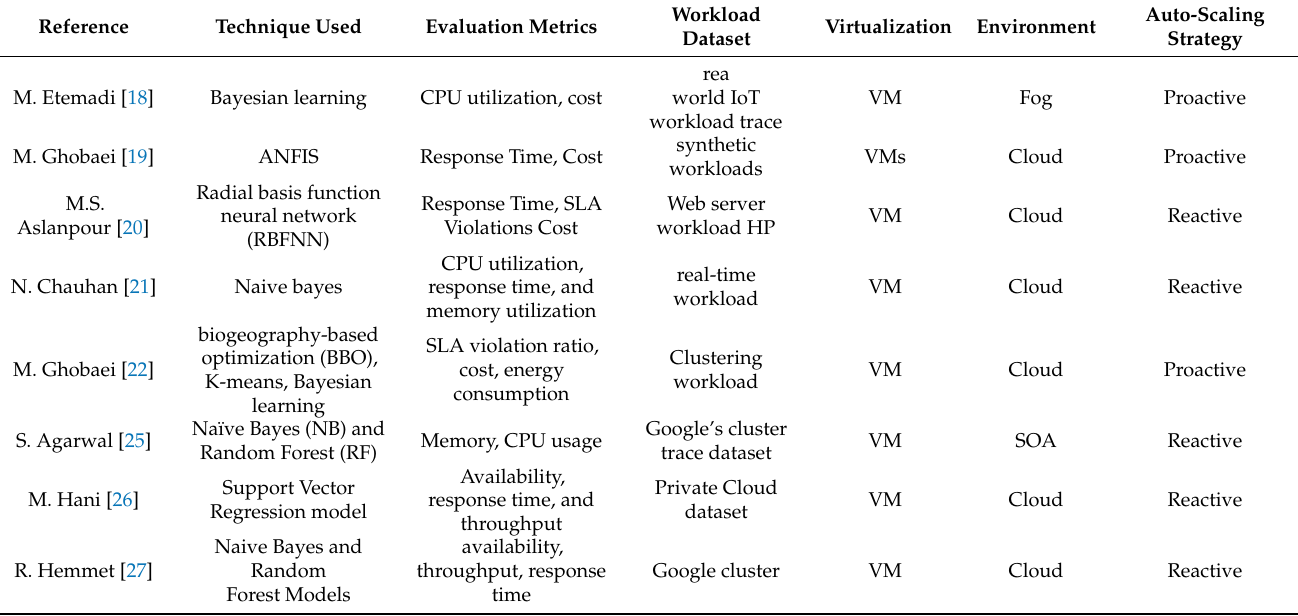
Table 1. Survey of studies related to Cloud Scalability and resource provisioning